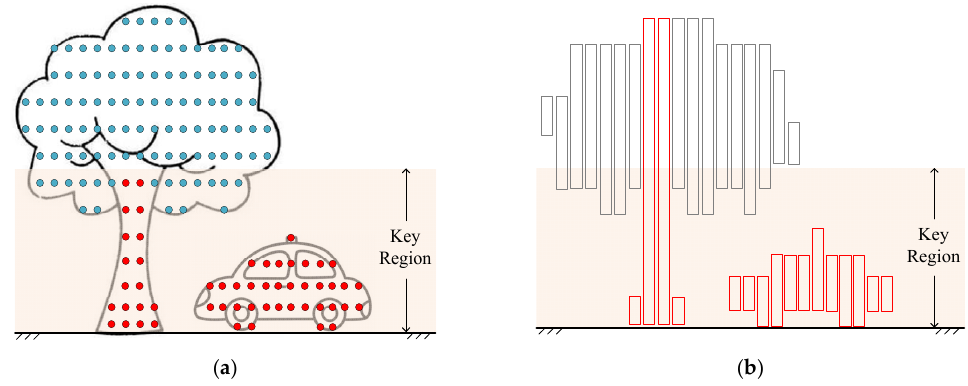
Figure 6. Schematic diagram of separating valuable object points (VOPs) and worthless object points (WOPs). ( a ) The schematic diagram showing the key region and key valuable points in the key region; ( b ) The schematic diagram of obtaining all valuable slices in the point cloud based on the key valuable points in the key region.